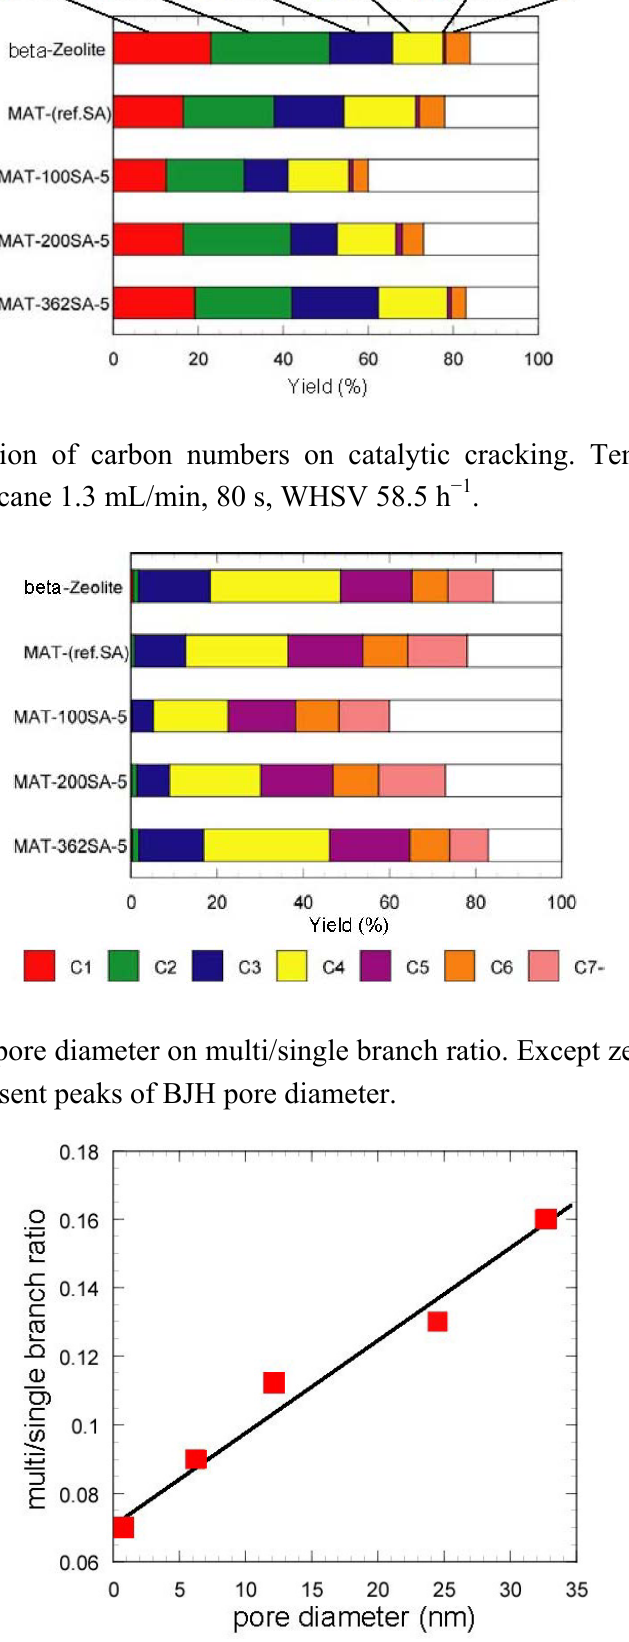
Figure 7. Yields for Paraffins, Olefins, Naphthenes and Aromatics on catalytic cracking. Temperature 500 °C, Catalyst 1 g, n -dodecane 1.3 mL/min, 80 s, WHSV 58.5 h − 1 .